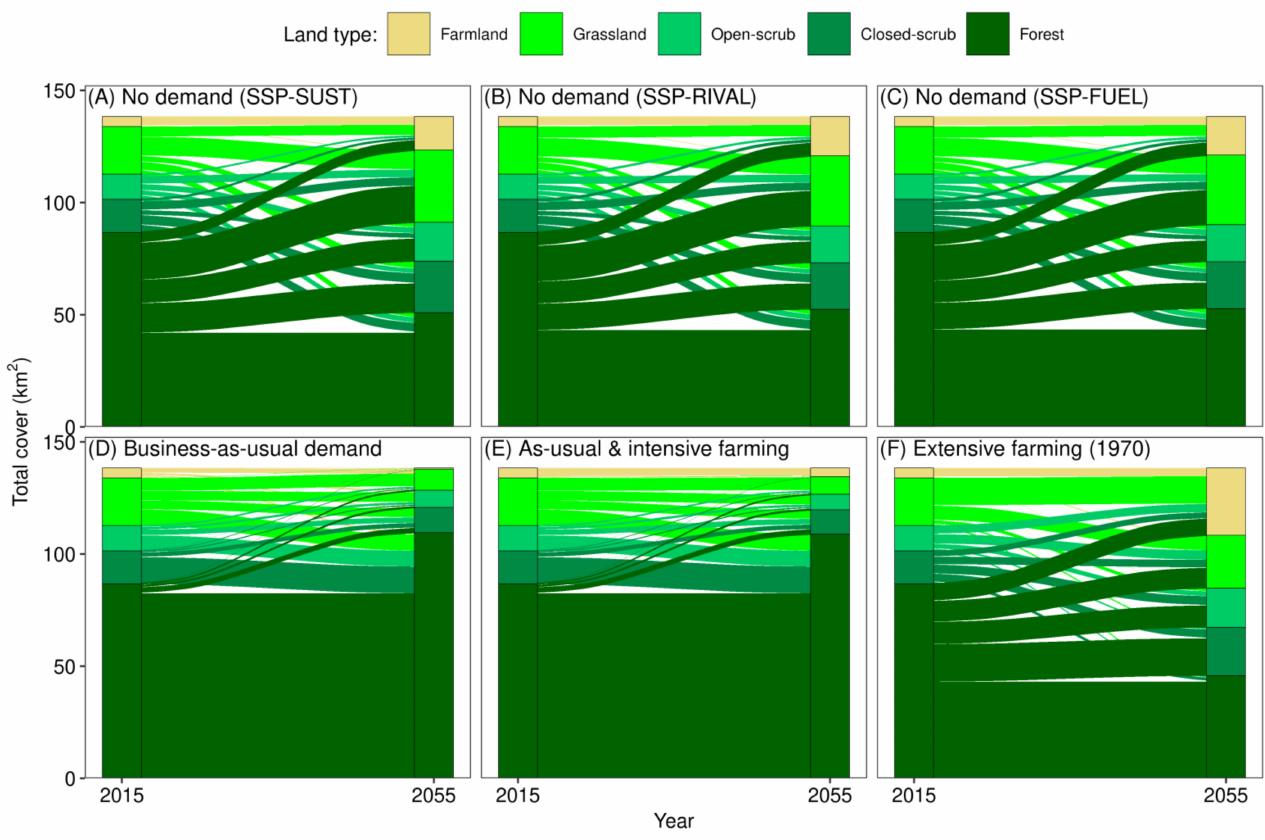
Figure 3. The LUC type cover and transitions over the 2015–2055 prediction period. The bars show the cover of each LUC type. The flows show the LUC transitions during the: ( A ) most optimistic climatic scenario with no pre-specified demand in 2015–2055 LUC transitions; ( B ) intermediate climatic scenario with no demand; ( C ) least-optimistic climatic scenario with no demand; ( D ) business-as- usual pre-specified demand from 1996–2015 to 2015–2055; ( E ) business-as-usual pre-specified demand but with the 2015 intensive farming preserved; and ( F ) pre-specified inverse transitioning to 1970 which had characteristics of extensive